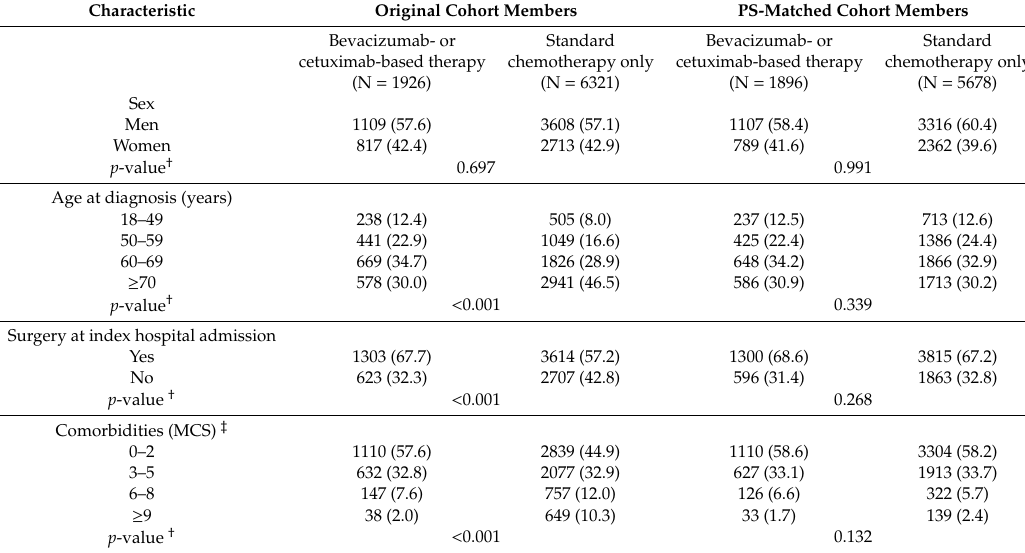
Table 1. Comparison between baseline characteristics of metastatic colorectal cancer patients belonging to the original and propensity score (PS)-matched cohorts on first-line treatment with biologic-based (bevacizumab or cetuximab) or standard chemotherapy alone. FABIO project, Italy,